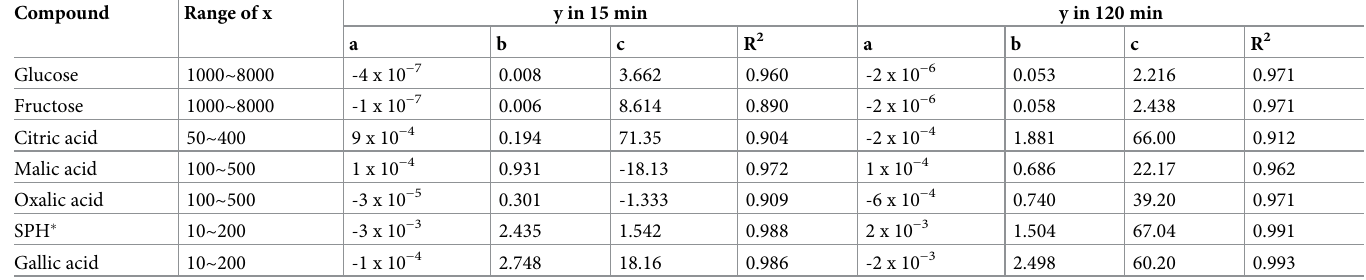
Table 3. Quadratic models derived for predicting chlorine demand (y, in mg/L) of different chemical compounds by their concentrations (x, in mg/L). The models are written as y = ax 2 + bx + c. Compound Range of